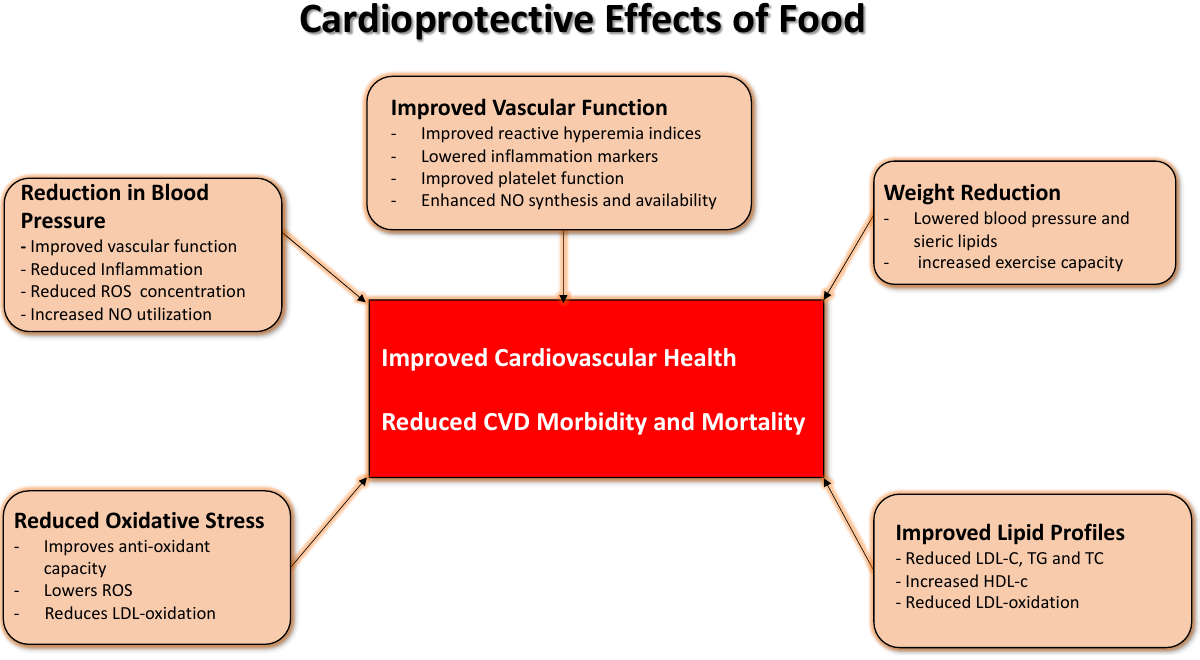
Figure 1. Proposed collective mechanisms to underpin the protective effect of foods against cardio- vascular disease. No single ingredient or agent can account for specific food groups’ benefits. It takes a calorically sensitive and balanced variety to get the maximum help for the patients.